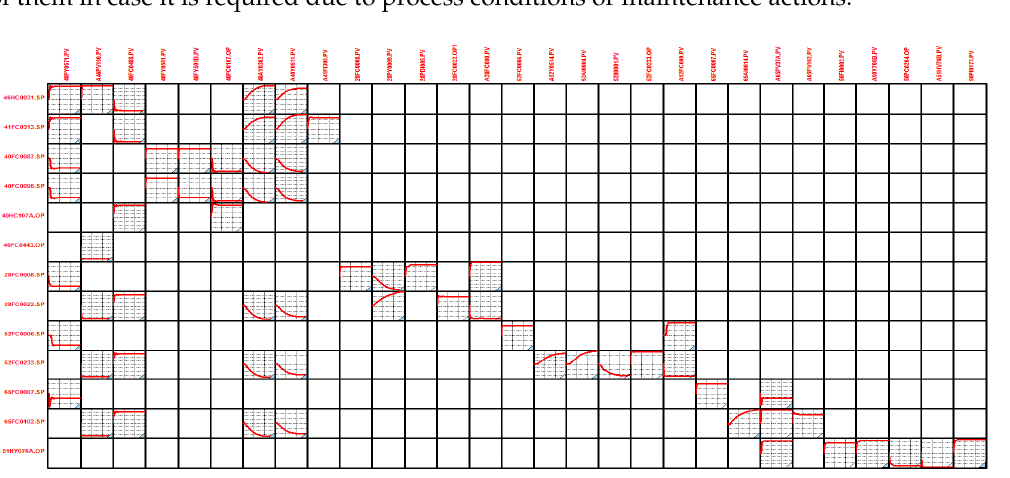
Figure 7. Diagram of the DMC controlling the operation of two hydrogen producers H3 and H4 and